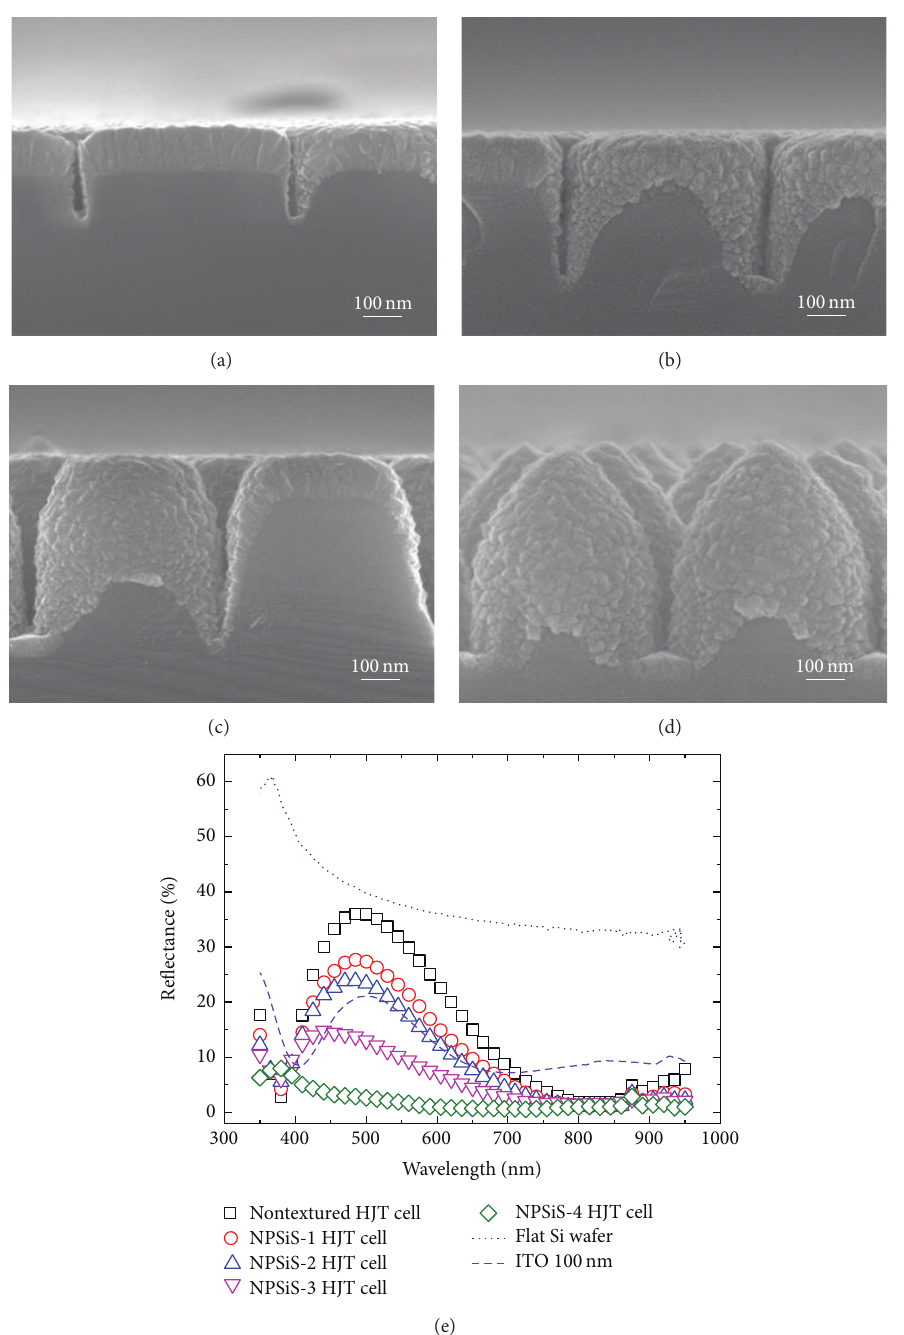
Figure 5: Side-view SEM images of NPSiS wafer following magnetron sputtering deposition on four NPSiS wafers. (a) NPSiS-1 HJT cell, (b) NPSiS-2 HJT cell, (c) NPSiS-3 HJT cell, (d) NPSiS-4 HJT cell, and (e) reflectance spectra of NPSiS HJT cells and nontextured HJT